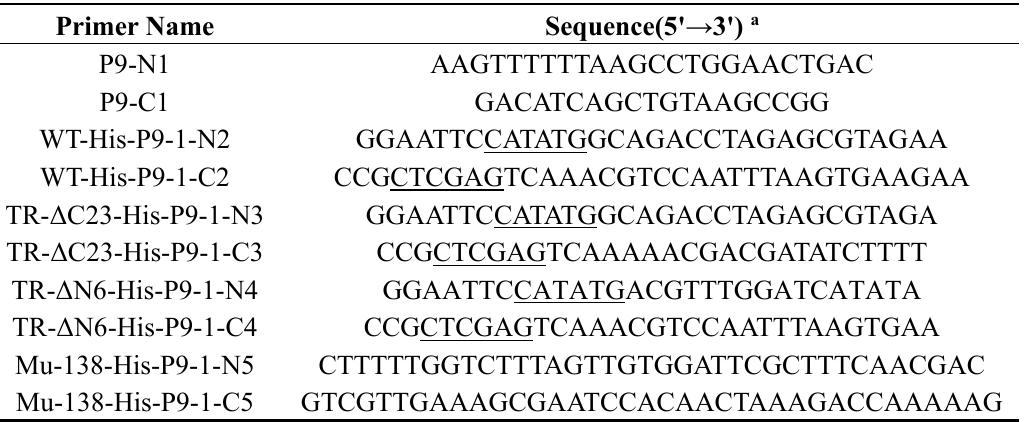
Table 1. Primers used in this